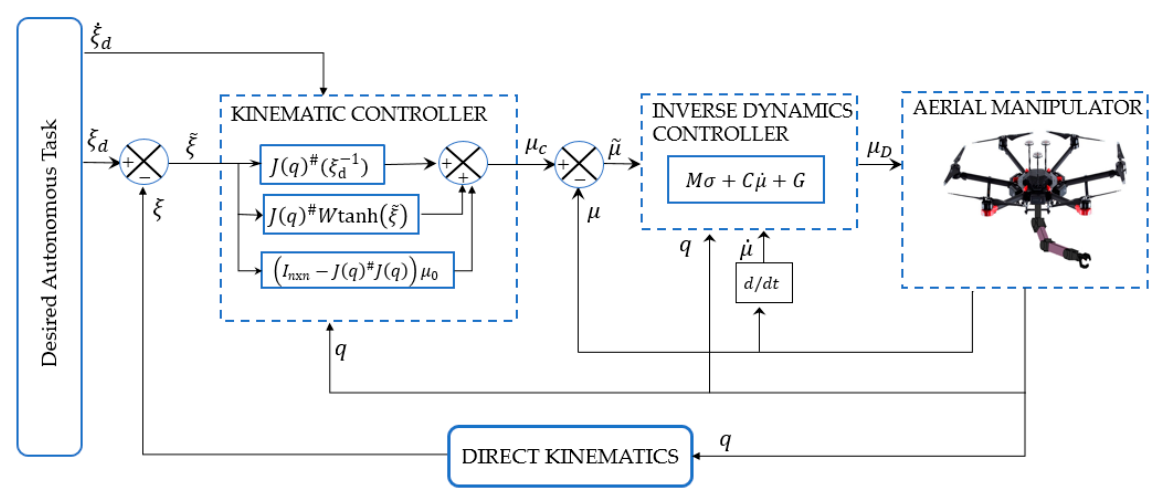
Figure 3. Proposed inverse dynamics controller scheme.